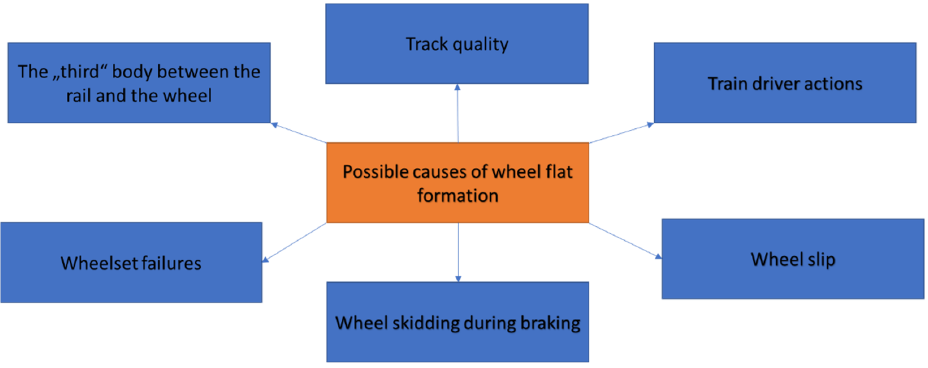
Figure 4. Main reasons of wheel flat formation.